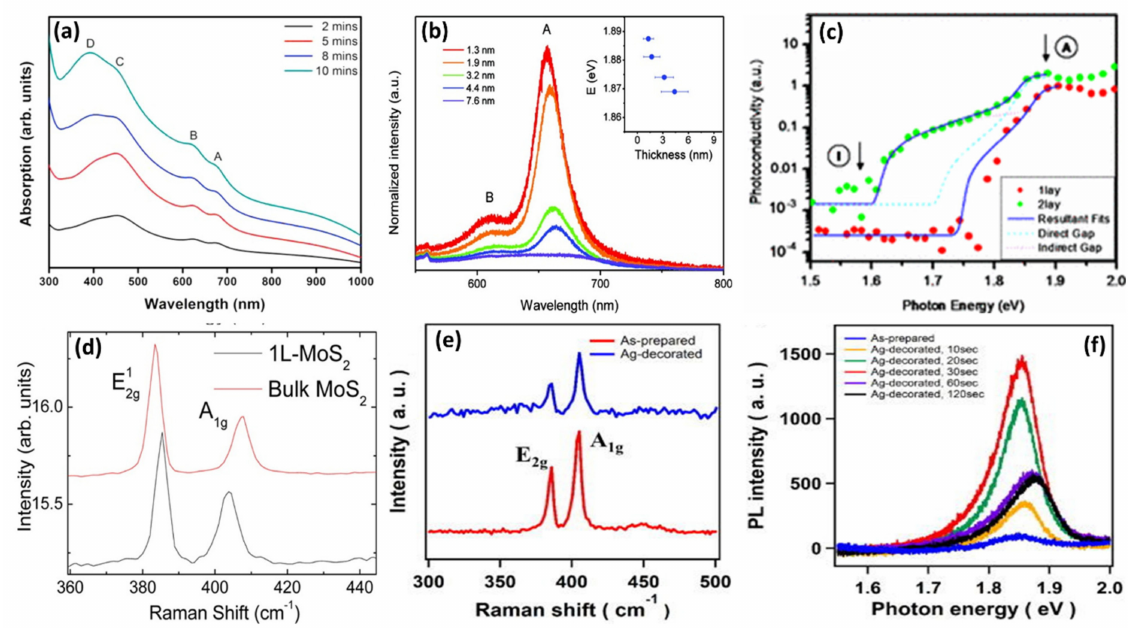
Figure 6. ( a ) UV–visible spectroscopy spectra of MoS 2 layers [168], ( b ) PL spectra of MoS 2 thin films with thicknesses ranging from 1.3 to 7.6 nm [46], ( c ) photoconductivity spectra for mono (red dots) and bilayer (green dots) MoS 2 [144]. ( d ) Raman spectra for (top) bulk MoS 2 , and (bottom) 1L-MoS 2 [167], ( e ) Raman spectra of MoS 2 before (red) and after (blue) Ag NP decoration [161], ( f ) PL spectra of MoS 2 decorated with Ag NPs [161]. Figures reproduced with permission from Ref.